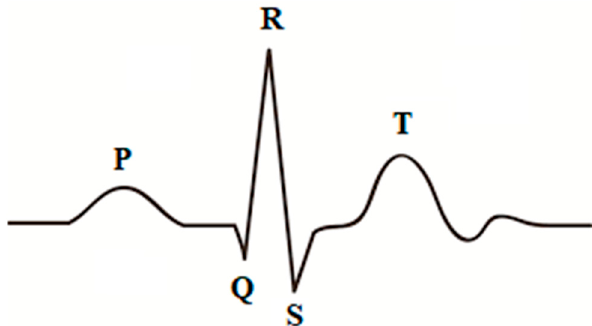
Figure 1. Single heartbeat.